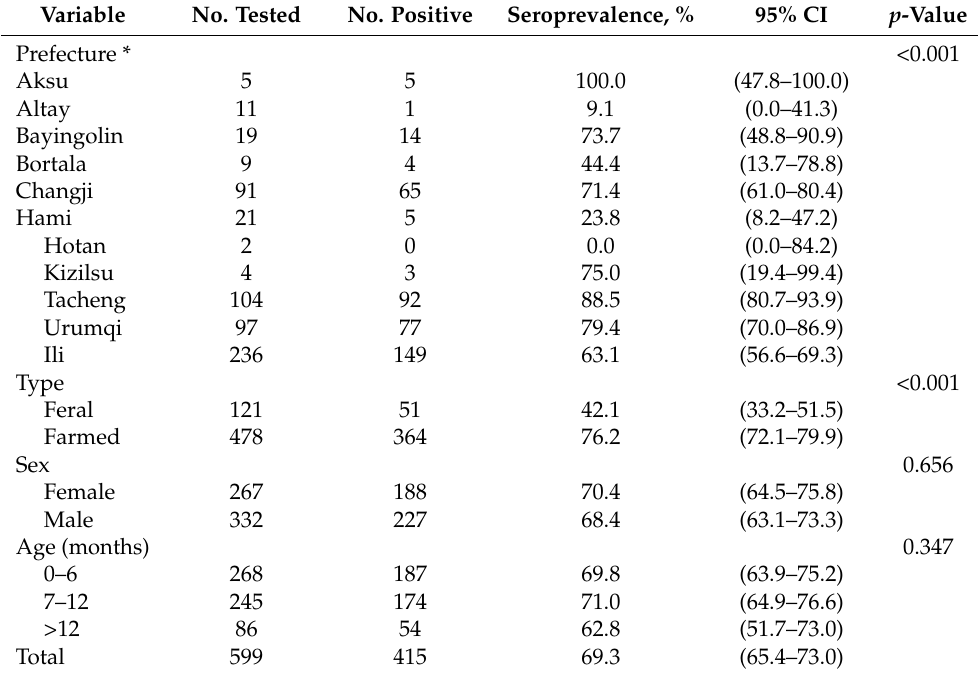
Table 2. Overall seroprevalence of HEV in feral and farmed wild boar